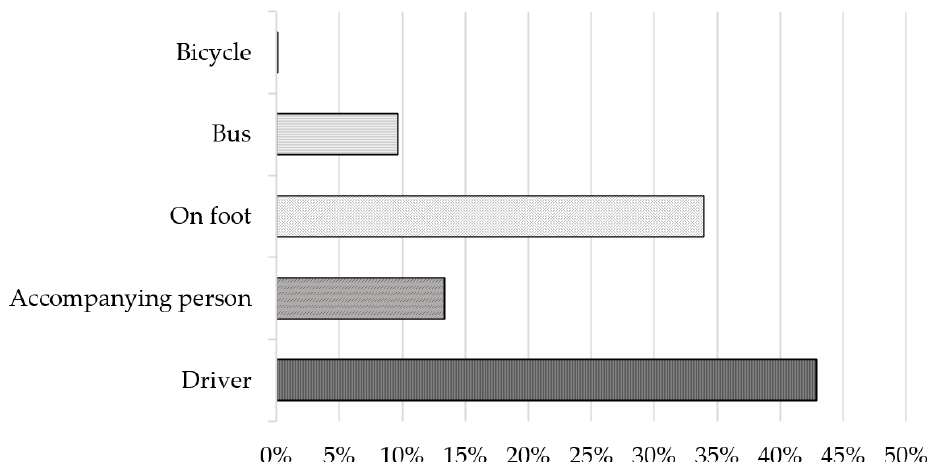
Figure 11. Travel modes of the city of Cáceres (PIMUS).